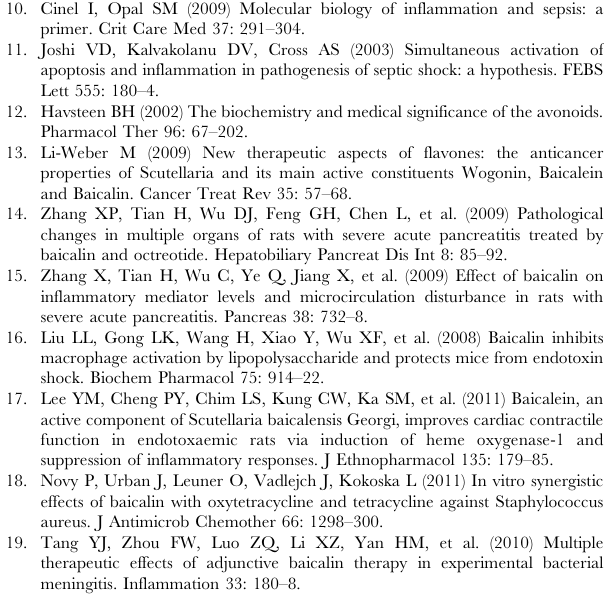
Figure S1 Gating on Gr-1 + neutrophils in peritoneum. Compared with the CLP group, the number of Gr-1 + neutrophils in mice treated with baicalin was decreased. (TIF) Figure S2 Gating on CD11c + DCs and CD19 + B cells in the spleen. Baicalin increased the numbers of CD 11c + dendritic cells, but not CD19 + B lymphocytes in the spleen. (TIF) Figure S3 Gating on CD4 + T, CD8 + T and CD4 + CD25 + T Cells (Tregs) in the spleen. Baicalin increased the numbers of CD4 + and CD8 + T lymphocytes, but reduced the number of regulative T cells in the spleen. (TIF) Figure S4 Gating on CD3 + T cells in the thymus. Apoptosis of CD3 + T cells in the thymus was inhibited after treatment with